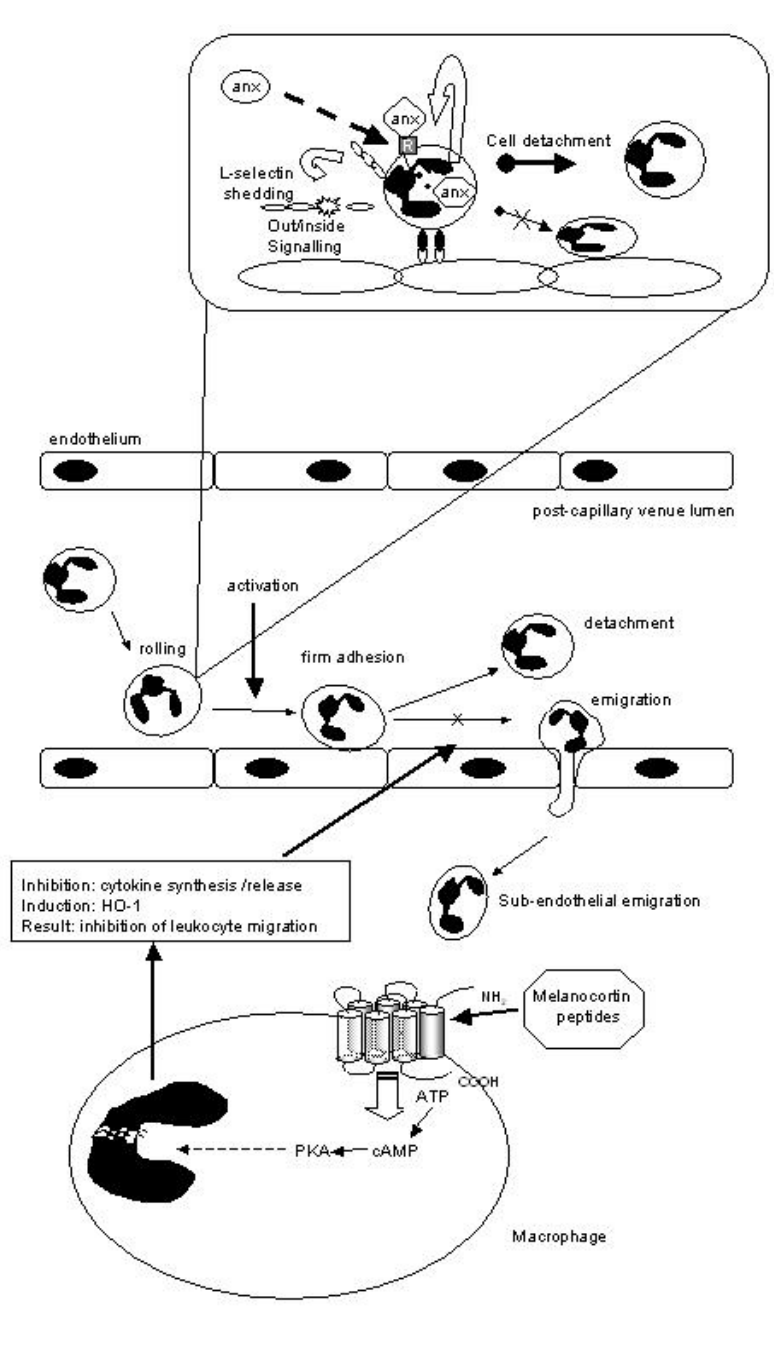
FIGURE 3. Schematic representation of the anti-inflammatory effects of the annexin and melanocortin peptides. Annexin 1 causes detachment of neutrophils from the endothelium by being released from gelatinase granules to the surface on activation of the cell. The detachment process could occur via two mechanisms: (1) the full-length protein could interact with receptor(s) to down-regulate neutrophil migration or (2) the protein is cleaved to make smaller pharmacologically active peptides that can also bind to the receptor and prevent neutrophil migration and also effect L-selectin shedding (highlighted in the smaller cartoon). The melanocortins display a different mechanism for modulating the host inflammatory response, resident MØ express MC3-R and agonism here leads to accumulation of cAMP with consequent activation of PKA. At least two major effects occur, with an early inhibition of release of proinflammatory cytokines/chemokines within the first 4 h and at later time- points, >4–6 h, the induction of the stress protein HO-1. Either mechanism of action can impact on the host inflammatory response and be responsible for the potent and reproducible antimigratory effects that melanocortin peptides exert in the context of acute local and systemic inflammation. The net effect with these endogenous peptides is that they modulate the host inflammatory response leading to a homeostatic balance within the